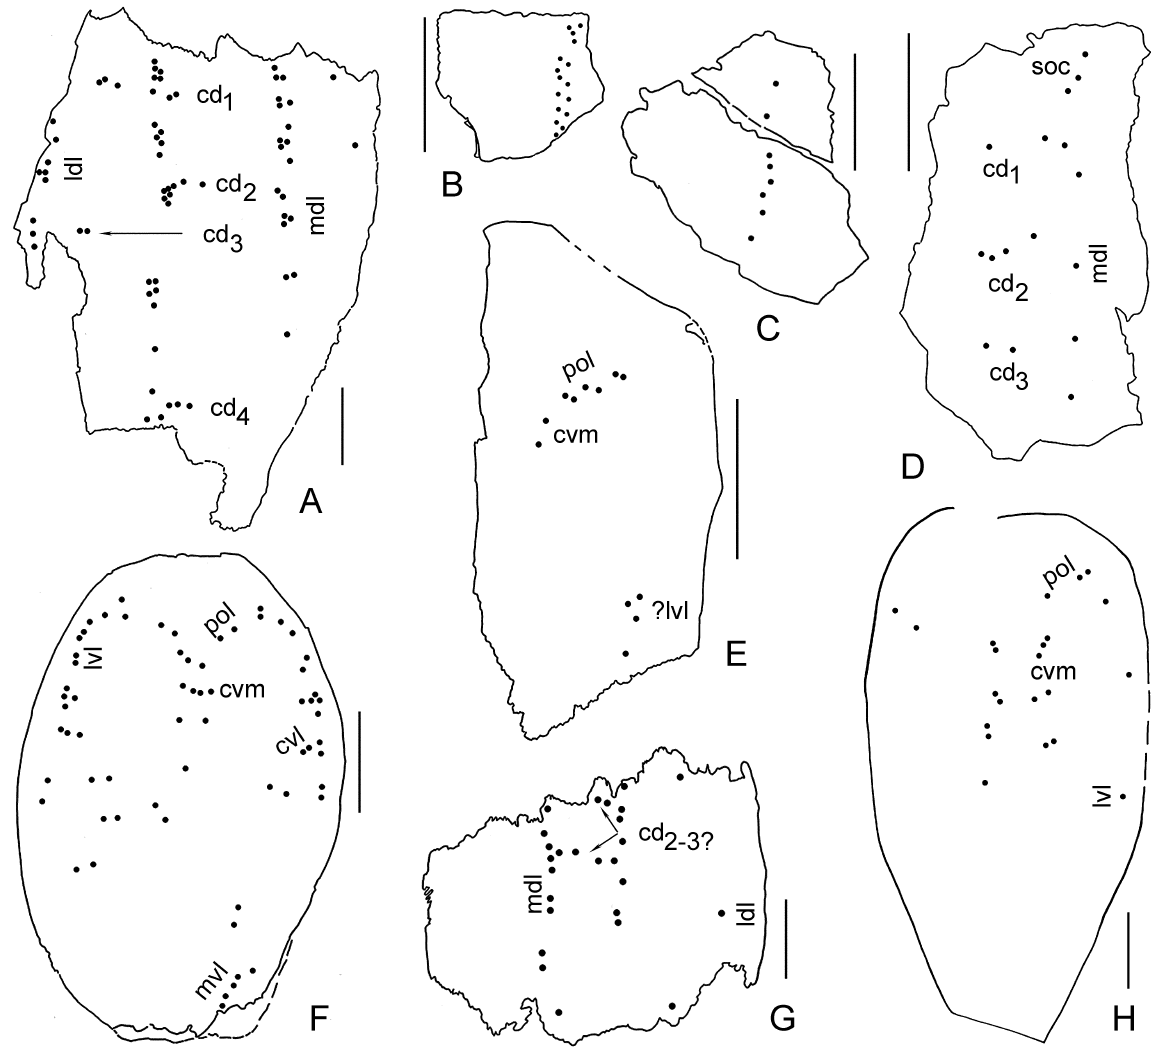
Fig. 6. Pores of lateral line canals (pores shown larger than they are in reality): A–E , Archegonaspis integra (Kunth); F , G , Tolypelepis undulata Pander; H , Tolypelepis bedovensis sp. nov. A, dorsal shield, GIT 721-1; B, dorsal shield, GIT 408-3; C, dorsal shield, GIT 408-7; D, dorsal shield, GIT 408-6; E, ventral shield, GIT 408-2; F, ventral shield, TUG 68-1; G, dorsal shield, GIT 721-3; H, ventral shield, GIT 721-7. Scale bars = 5 mm (A–E, G, H); 1 cm (F). Locations : A, Reo-927 core, depth 8.9 m, Saaremaa, Estonia, Tahula Beds of the Kuressaare Stage, upper Ludlow; B–E, locality 85-042, Tabuska (Vishnevaya Gora) section, the Central Urals, Tabuska Beds either of the lower P ř idoli (Shujskij 1981; Shurygina et al. 1981) or upper Ludlow level (Modzalevskaya & Märss 1991); F, Ohesaare Cliff, Saaremaa, Estonia; G, Kolka-54 core, depth 162.5 m, Latvia, Ohesaare Stage, upper P ř idoli; H, Bedovaya River section, October Revolution Island, Severnaya Zemlya Archipelago, Krasnaya Bukhta Formation, upper P ř idoli, upper Silurian. Abbreviations (following Denison 1964): cd 1-4 , first to fourth dorsal transverse commissures cvl, lateral ventral transverse commissure; cvm, medial ventral transverse commissure; ldl, lateral dorsal canal; lvl, lateral ventral canal; mdl, medial dorsal canal; mvl, medial ventral canal; pol, postoral canal; soc, supraorbital